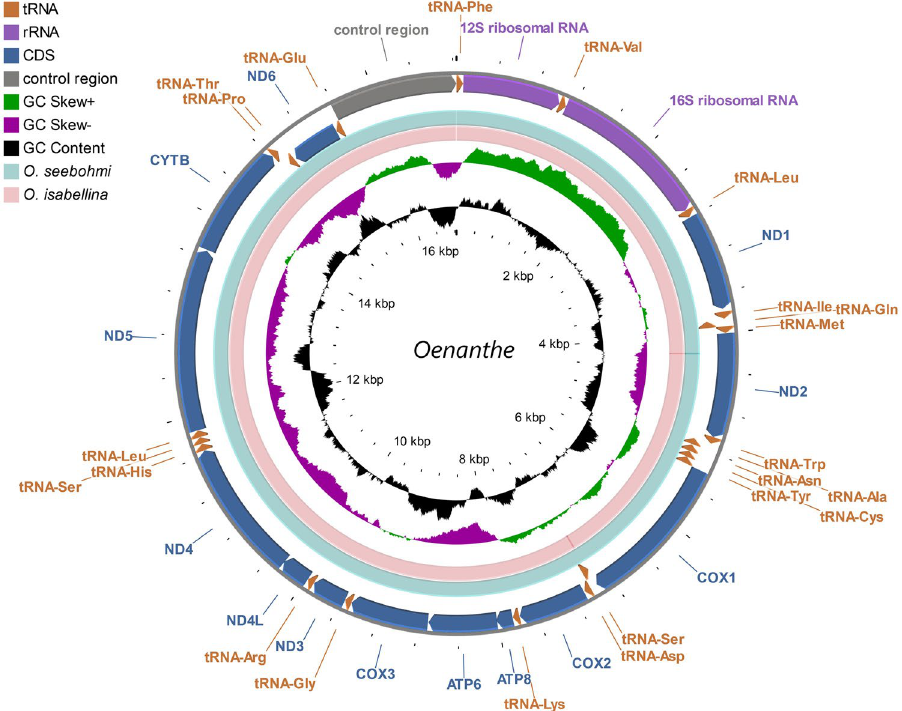
Figure 1. Circular map of the mitogenome of Oenanthe oenanthe assembled from NGS data. Features are represented by different color blocks. Arrows indicate the orientation of the gene transcription. The GC content and GC skew were calculated using a sliding window and plotted as the deviation from the average value of the entire sequence. The BLAST comparisons of Oenanthe oenanthe with Oenanthe seebohmi and Oenanthe oenanthe with Oenanthe isabellina are shown in divider